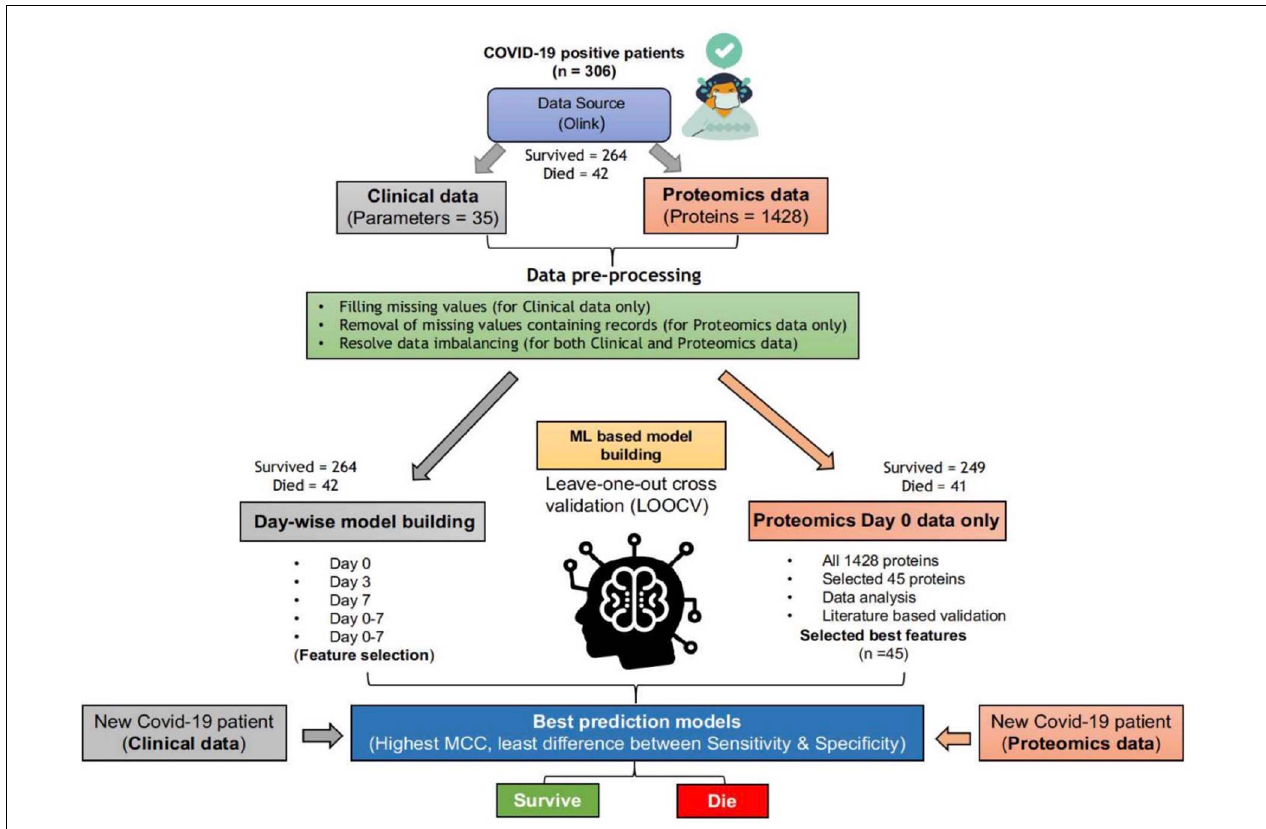
FIGURE 1 | ML-based pipeline to identify key features associated with survival based on clinical and proteomics data. (The figure images were generated using